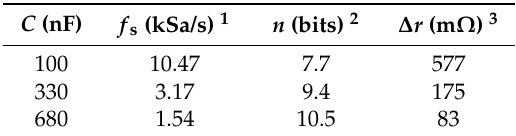
Table 1. Effect of the C value on the sampling frequency and the resolution of the DIC when measuring a resistive sensor with R x ,0 = 743 Ω and ∆ R x ,max = 120 Ω